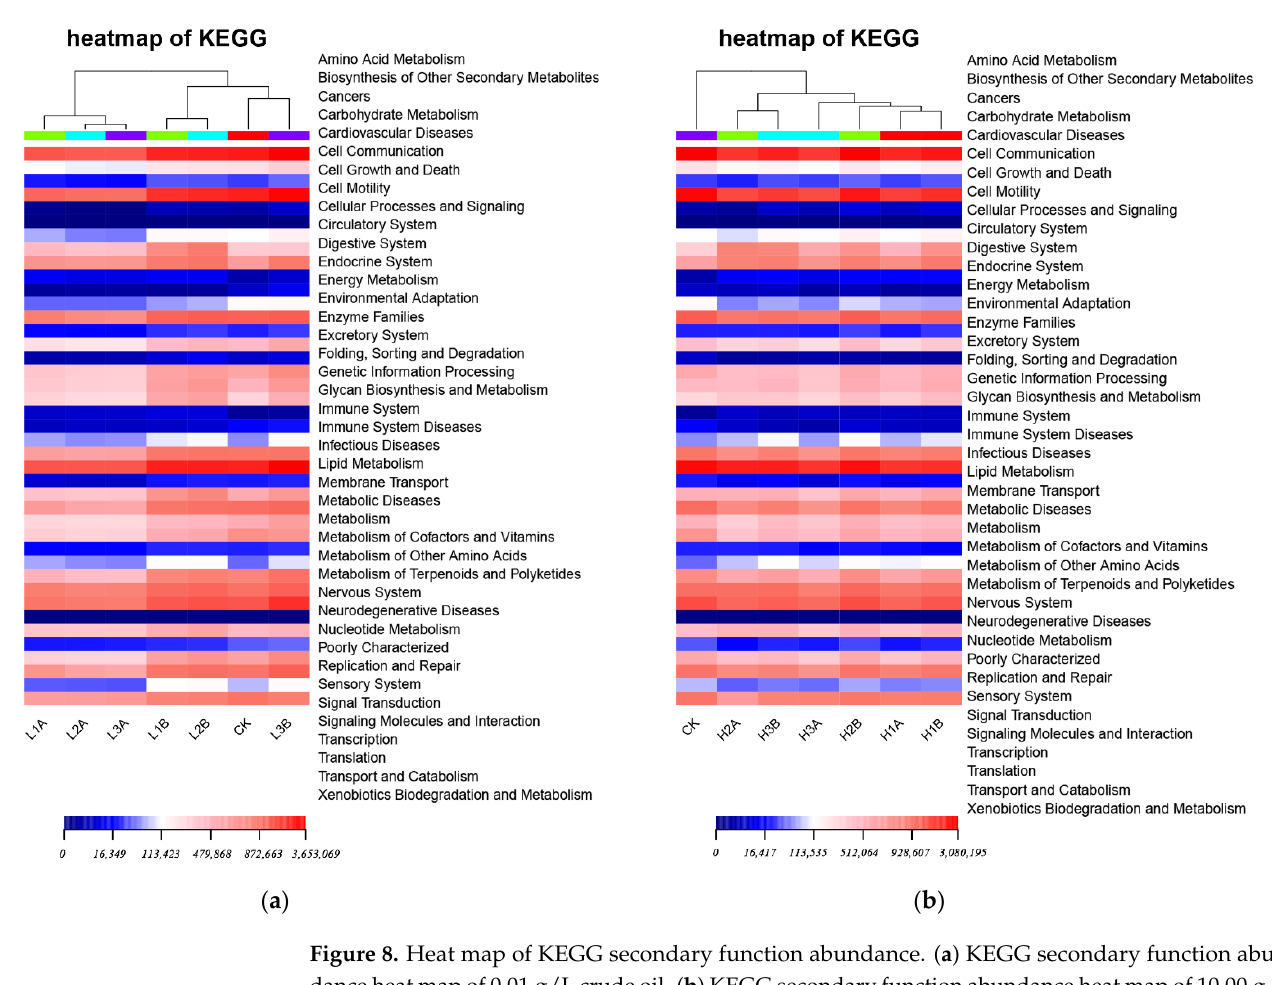
Figure 8. Heat map of KEGG secondary function abundance. ( a ) KEGG secondary function abun- dance heat map of 0.01 g/L crude oil. ( b ) KEGG secondary function abundance heat map of 10.00 g/L crude oil.